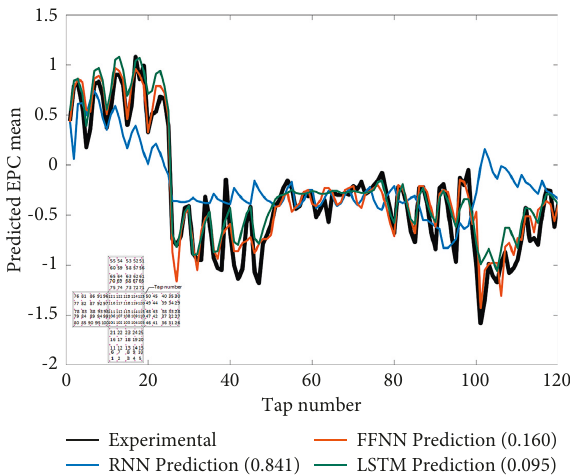
Figure 11: Comparison of the experimental EPC predicted by the trained ANN models for all the taps for θ � − 10 ° . Numbers inside brackets indicate the MSE